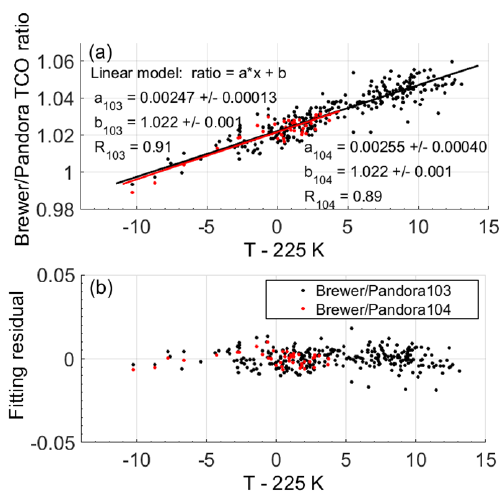
Figure 6. Linear regression of Brewer / Pandora TCO ratio as a function of effective temperature minus 225K. (a) Linear regres- sion results; (b) residual plot of the linear